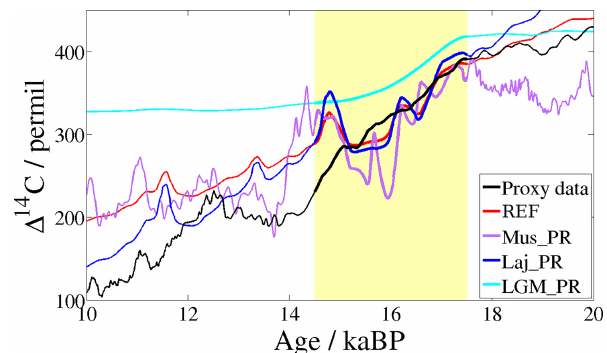
Figure 7. (cid:49) 14 C in transient simulations with all changes (see Sect. 3.1) applying different 14 C production rates: from Hain et al. (2014) (red, REF), Muscheler et al. (2004) (magenta, Mus_PR), Laj et al. (2004) (blue, Laj_PR) and fixed LGM production rate (cyan, LGM_PR) and data-based reconstructions from Reimer et al. (2013)